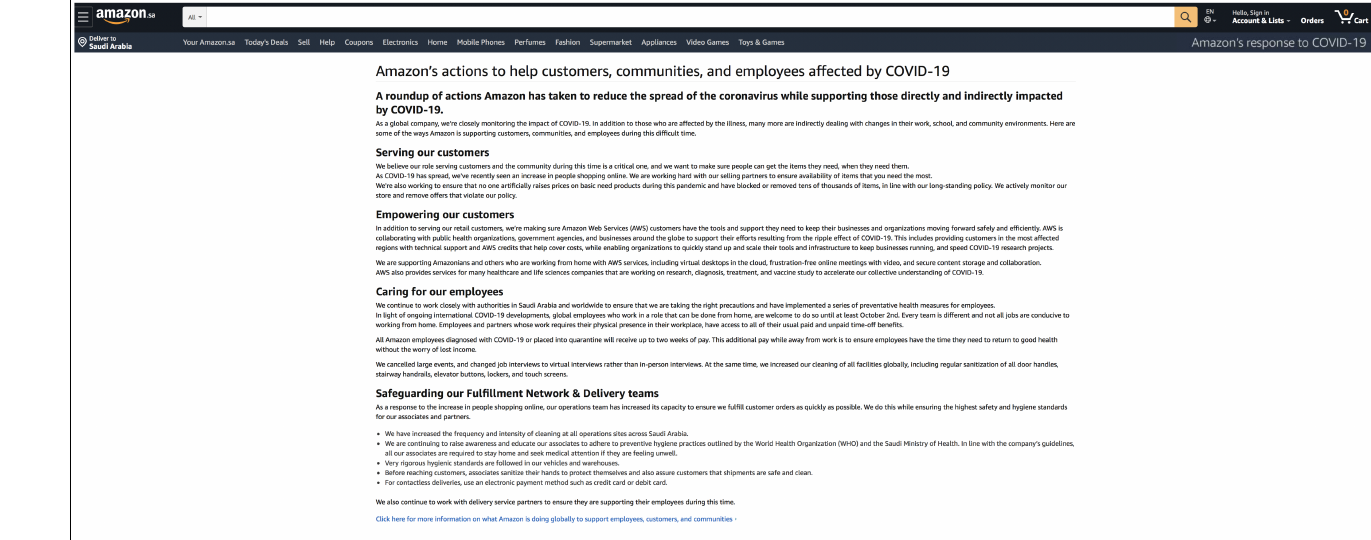
Figure 1. Information about Precautionary Measures Adopted By Amazon During COVID-19 Pandemic. Source (https: //www.amazon.sa) accessed on 20 July